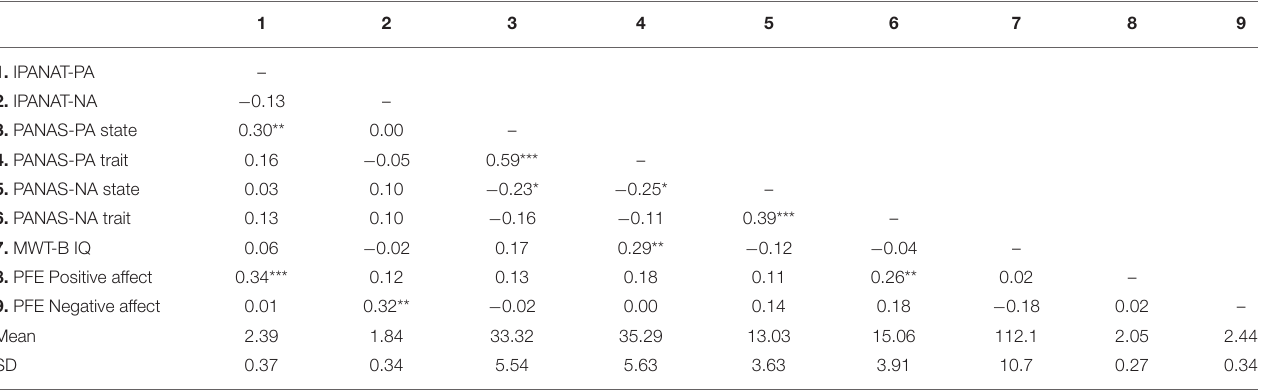
TABLE 1 | Descriptive statistics and correlations between psychological measures.